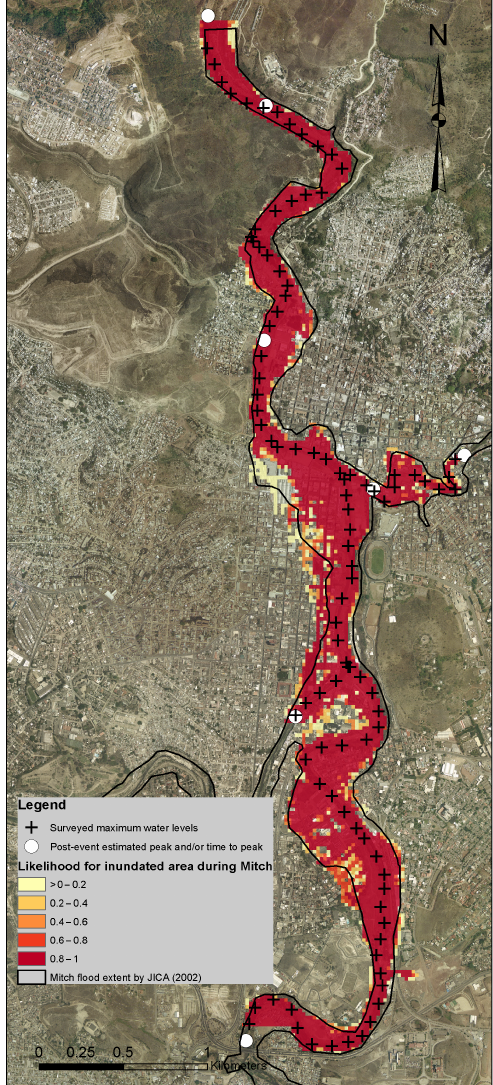
Figure 12. Likelihood of inundated area during the Mitch event on 30–31 October 1998, considering uncertainty in model parameters, model input, and evaluation data to drive and constrain a combina- tion of rainfall–runoff and hydraulic modelling tools. The determin- istic flood extent was obtained by digitalization of the flood extent in JICA